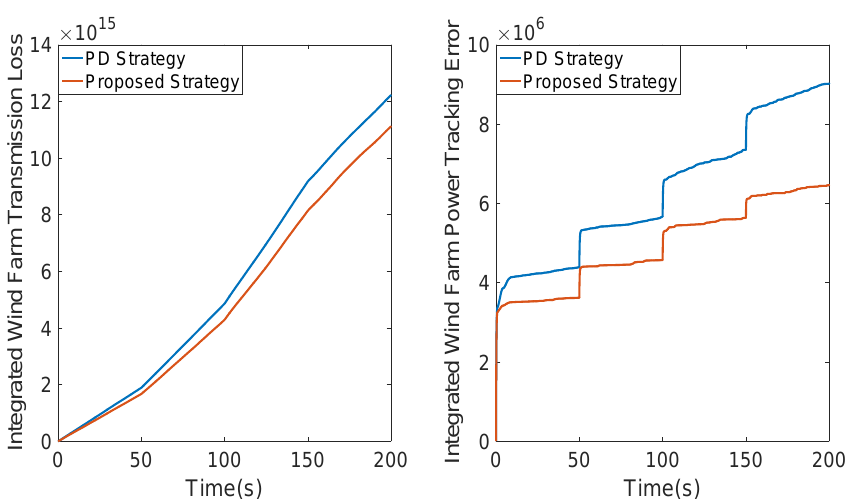
Figure 6. Integrated wind farm power tracking absolute error and integrated transmission loss. Table 2. P IAE & M I at 200s (PD: Proportional Distribution)